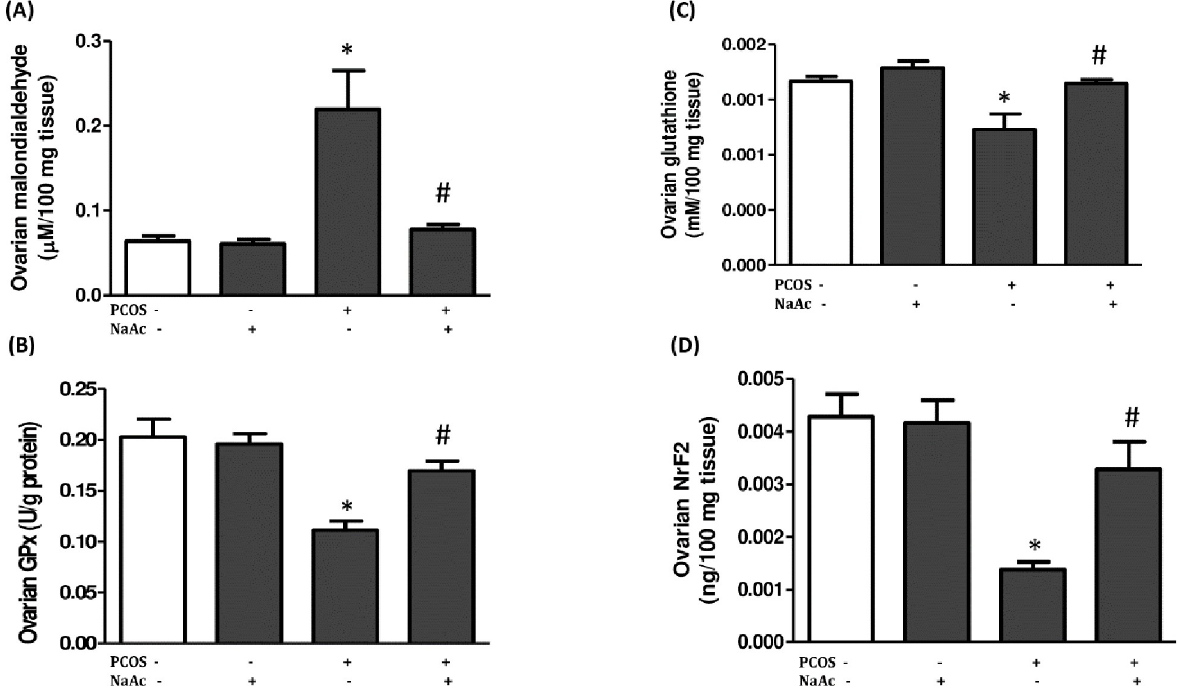
Fig 5. Impact of sodium acetate on ovarian malondialdehyde (a), glutathione peroxidase (b), reduced glutathione (c) and Nrf2 (d) in LET-induced PCOS rat model. Data are expressed as mean ± SD. n = 6. Data were analyzed by one-way ANOVA followed by Bonferroni post hoc test . ( � p < 0.05 VS. CTL; # p < 0.05 VS. PCOS). Control (CTL); Polycystic ovarian syndrome (PCOS); Sodium acetate (NaAc); nuclear factor erythroid-derived 2–like 2